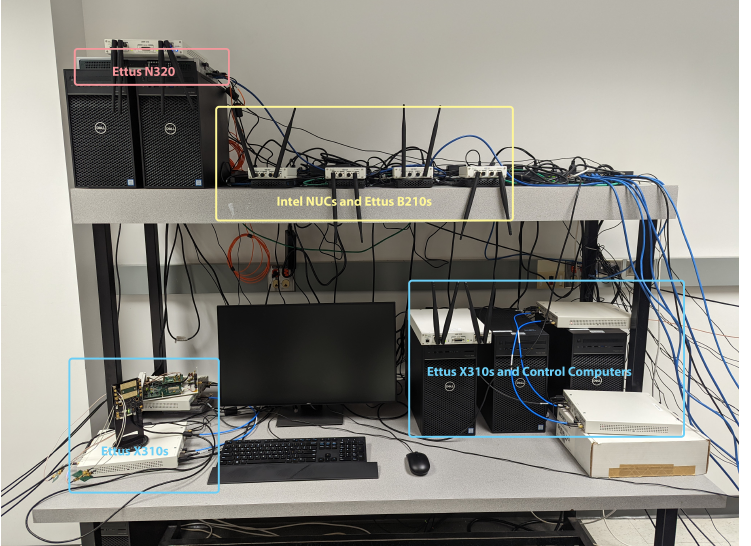
Figure 8. This WISCANet deployment features four Ettus X310s with UBX-160s sharing 10 MHz and PPS signals disciplined by the internal GPSDO. Each edge node uses two independent X310s for higher bandwidth transmit and receive. This deployment also features four Ettus B210s as independent edge nodes. One Ettus N320 is also included for embedded processor experiments. This deployment can be used for a variety of experiments in sub-6 GHz bands, emphasizing disparate processing capability, and adaptive waveform